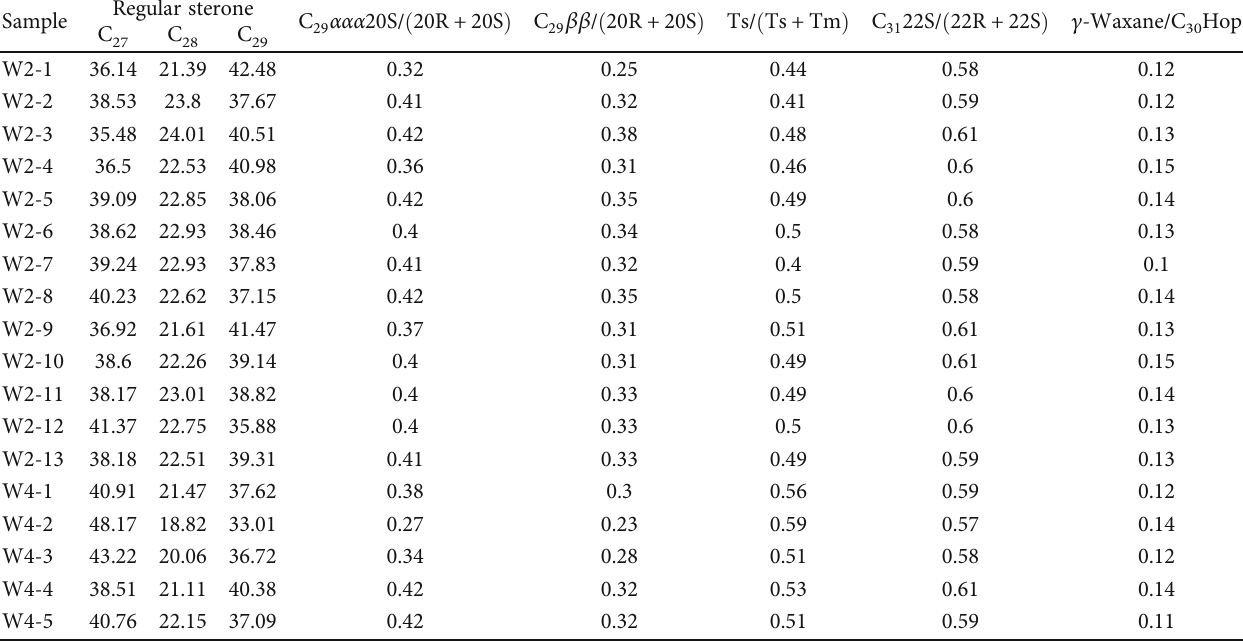
Figure 6: (a) Plot of CPI vs. OEP (the basemap is from [26]) and (b) plot of Pr/nC basemap is from [25]). Table 1: The results of GC-MS analysis of the saturated hydrocarbon in the Longtan shales. Regular Sample